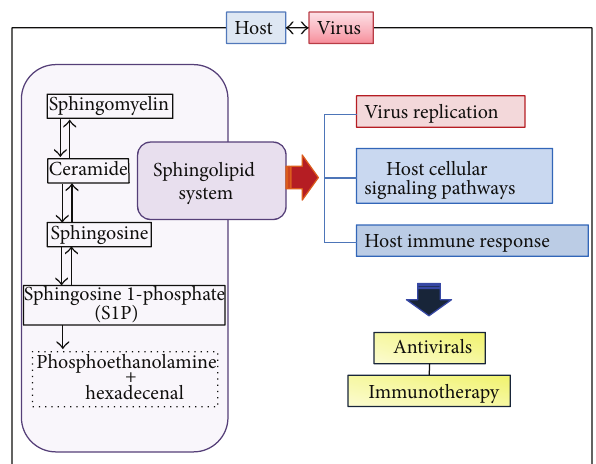
Figure 6: Diagram depicts the sphingolipid system regulating virus replication and host defense and signaling. The study of the sphingolipid metabolism/signaling during viral infection could allow us to develop new therapeutic approaches to clear virus